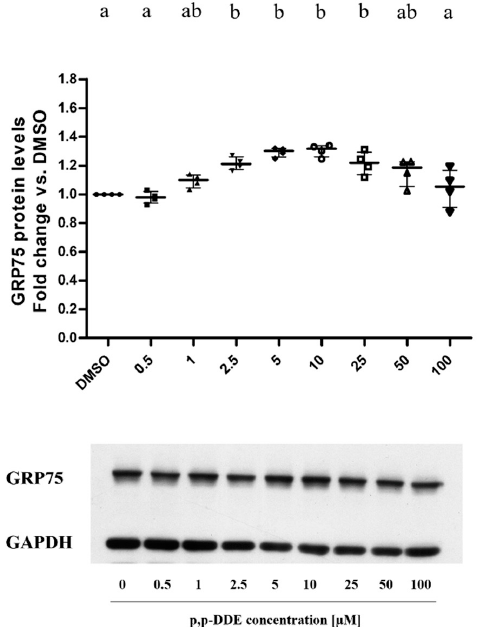
Figure 8. Mitochondrial antioxidant enzyme SOD2 protein levels. All data are presented as median with interquartile of range for 6 biological replicates. The figure showed representative images of SOD2 (below) and the relative loading control for protein normalization GAPDH (above). One-way ANOVA analysis followed by Bonferroni’s post-hoc test: different letters indicate statistically different values.